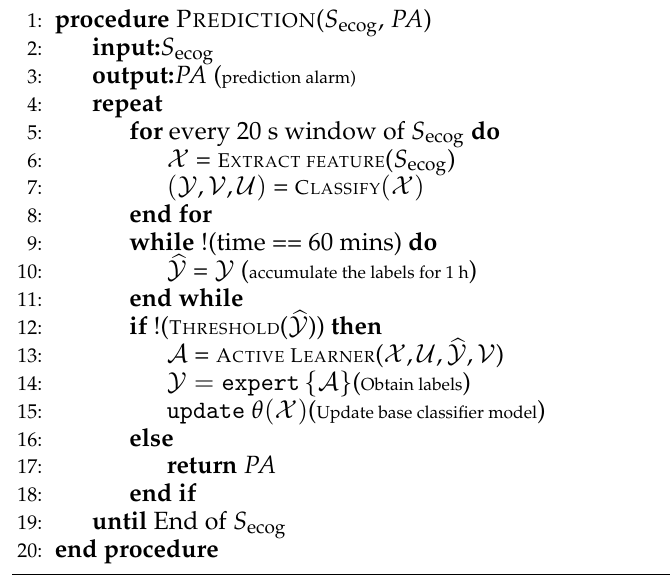
Algorithm 2 Pseudo-code of seizure prediction